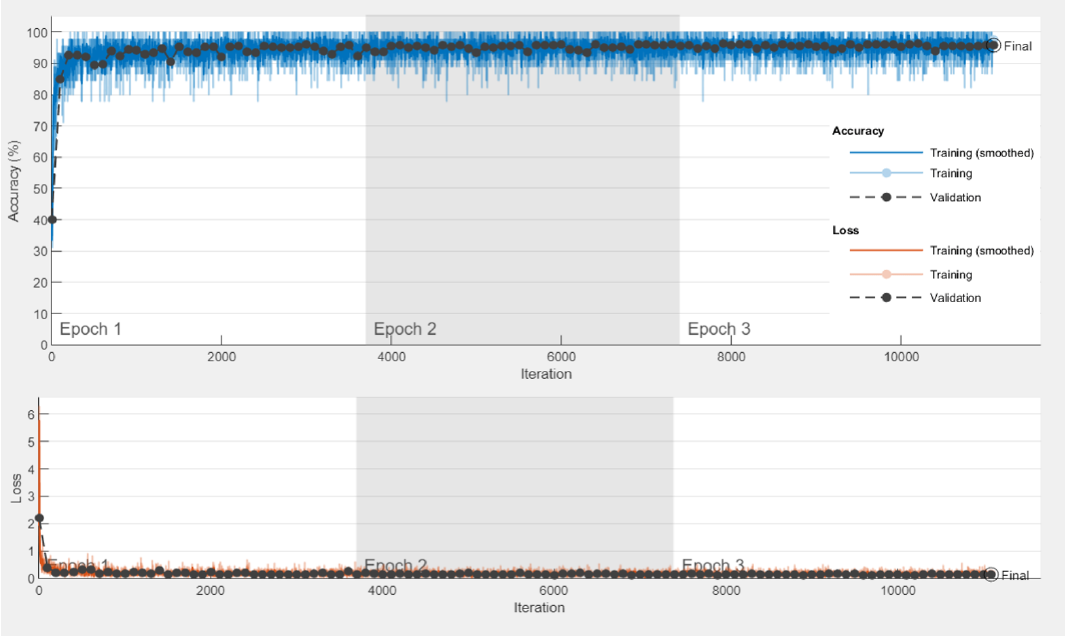
Figure 8. Training progress of mouth movement dataset.